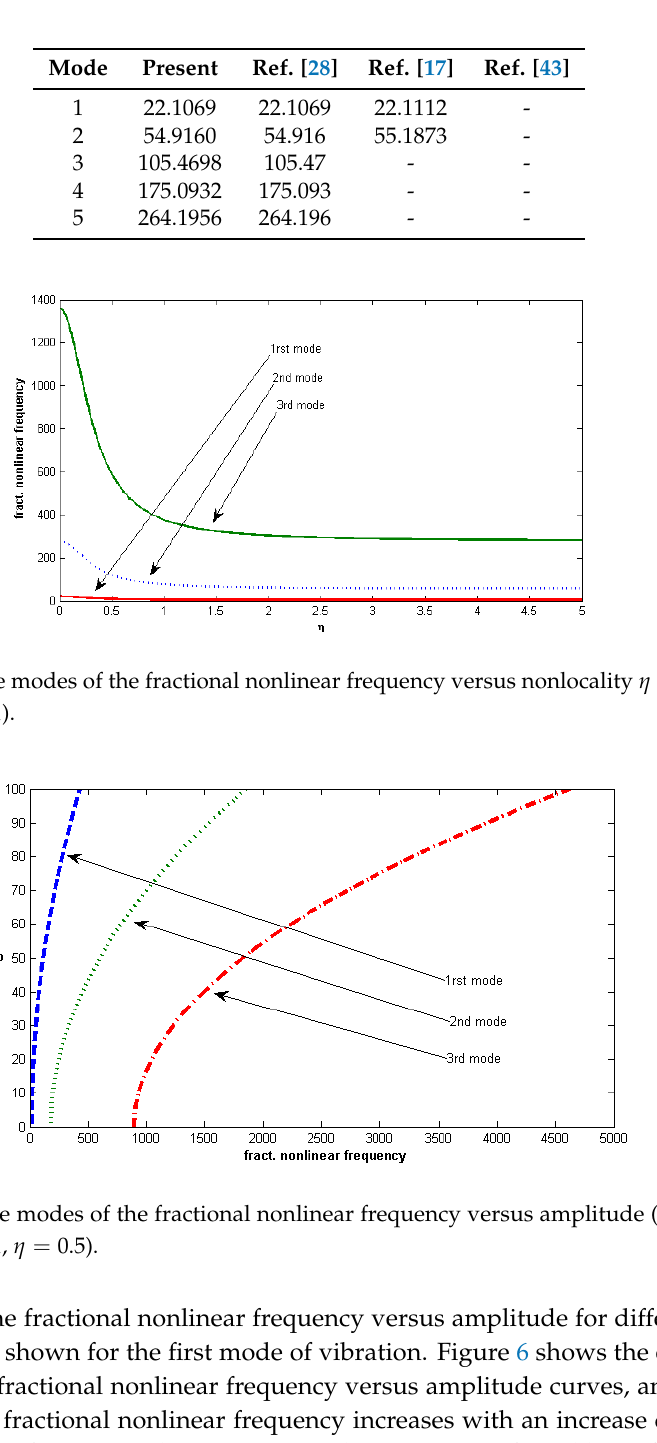
Table 2. The first five non-dimensional natural frequencies of a local Euler–Bernouilli beam resting on a Winkler–Pasternak foundation for the simple-simple boundary condition ( η = 0, δ = 0, K = 36, K p = 36 ) .